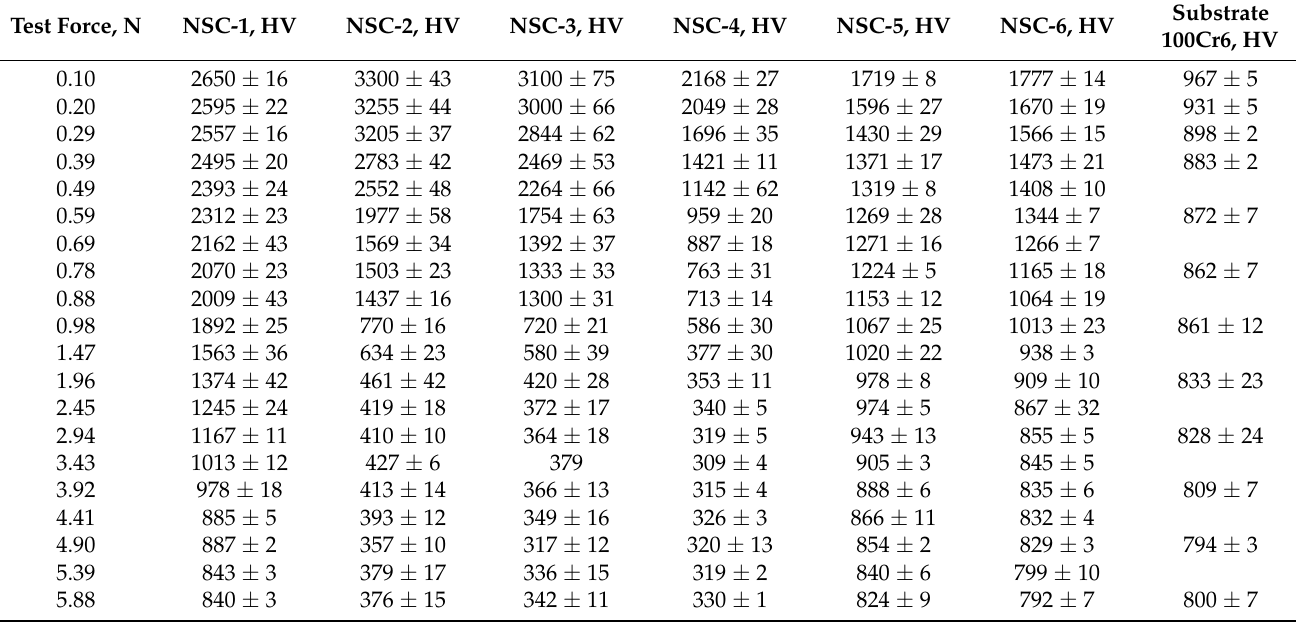
Table A1. Microhardness measurement values.